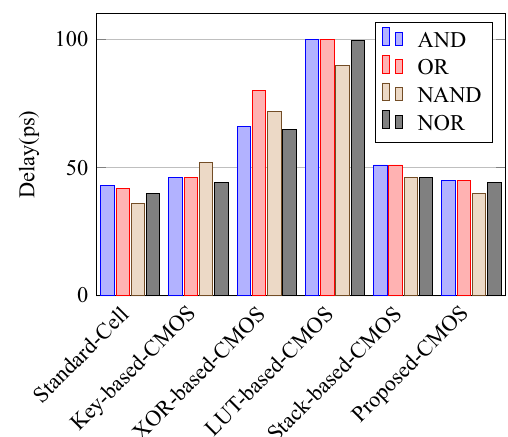
Figure 32. Delay of the each gate.